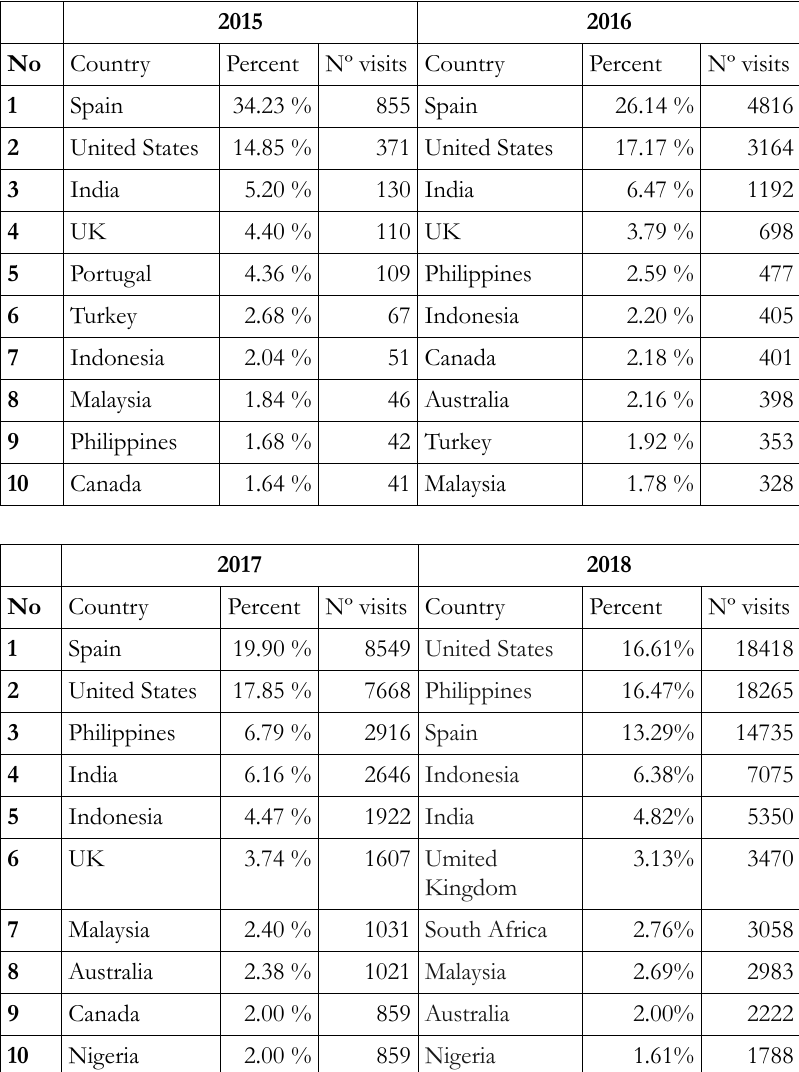
Table 3. JOTSE's visits from 4th November 2015 to 10th January